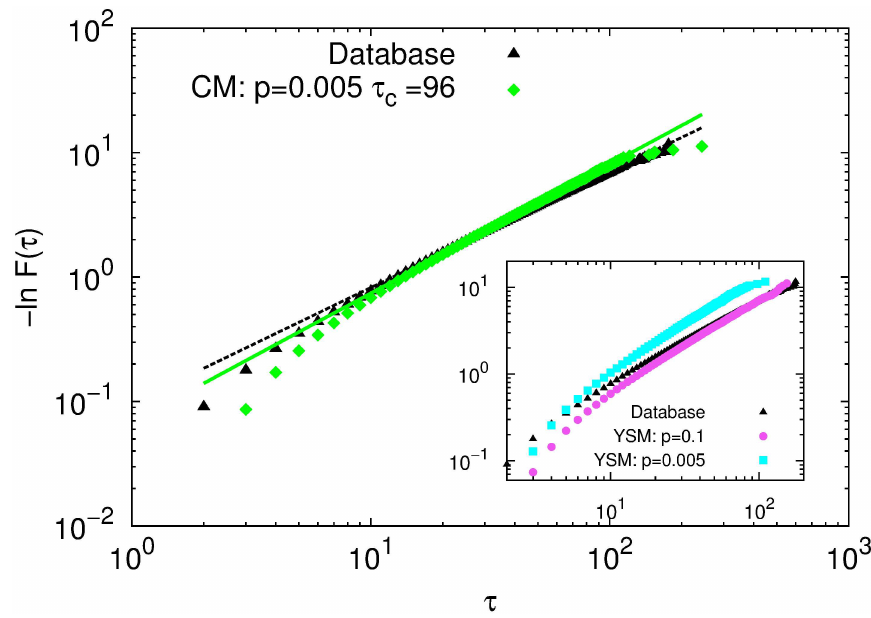
Fig 5. Cumulative distribution of inter-event times of the most popular opening-line measuredin the database (black triangles) and generated with CM for p = 0.005 and τ c = 96 (green diamonds). The lines are fits accordingto Eq (7) with β = 0.927 ± 0.003 ( R 2 = 0.999) for the database(black dashed line) and for CM with β = 1.035 ± 0.003 ( R 2 = 0.999) (green full line). Inset: cumulativefrequency distribution of inter-event times measuredin the database(black triangles), YSM for p = 0.1 (magenta circles) and p = 0.005 (cyan squares).